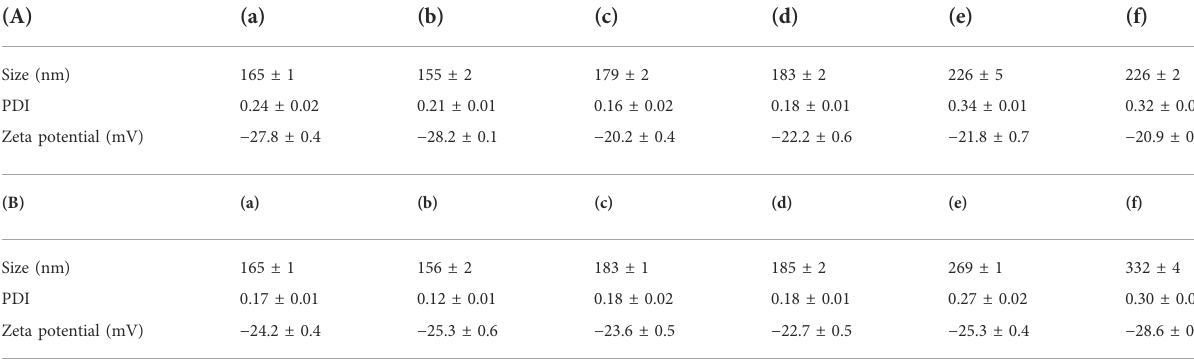
TABLE2Size,PDIandzetapotentialof(A)(a,c,e)Cy5-labeledOxi- α CDNPsand(b,d,f)Cy5-labeledFA-Oxi- α CDNPs;(B)(a,c,e)Cy5-labeledOxi- α CD NPs and (b, d, f) Cy5-labeled cRGD-Oxi- α CD